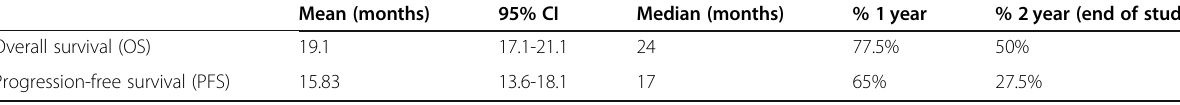
Table 5 Overall survival (OS) and progression-free survival (PFS) of the studied cases Mean